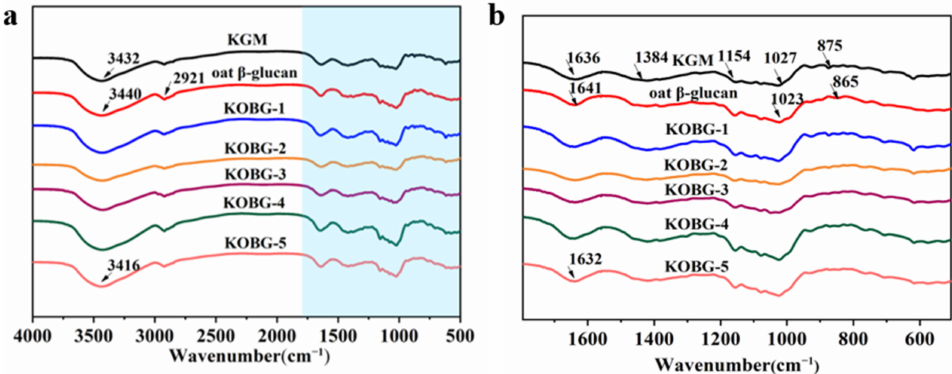
Figure 5. Fourier transform infrared spectroscopy (FT-IR) of composite hydrogel at 4000–500 cm − 1 ( a ); enlarged FT-IR of composite hydrogel at 1800–600 cm − 1 ( b